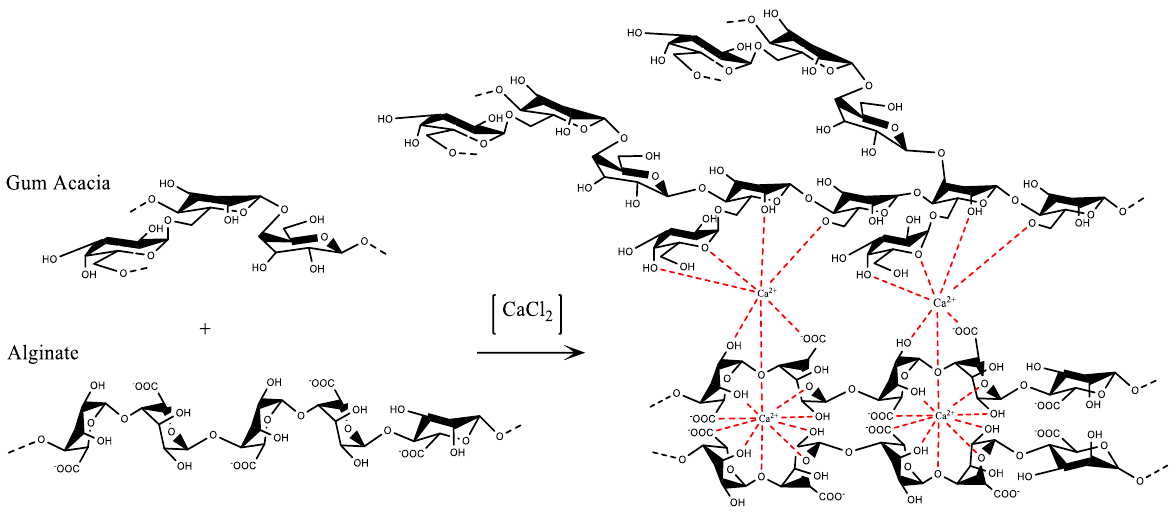
Figure 5. Interaction between alginate and gum acacia in CaCl 2 solution Pectin could form an egg-box structure in the presence of Ca 2+ ions as well as alginate.